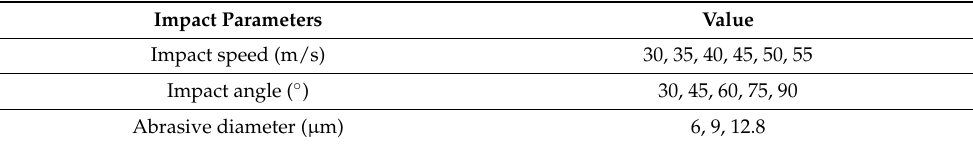
Table 2. Simulation parameters of a single particle impacting the optical glass.